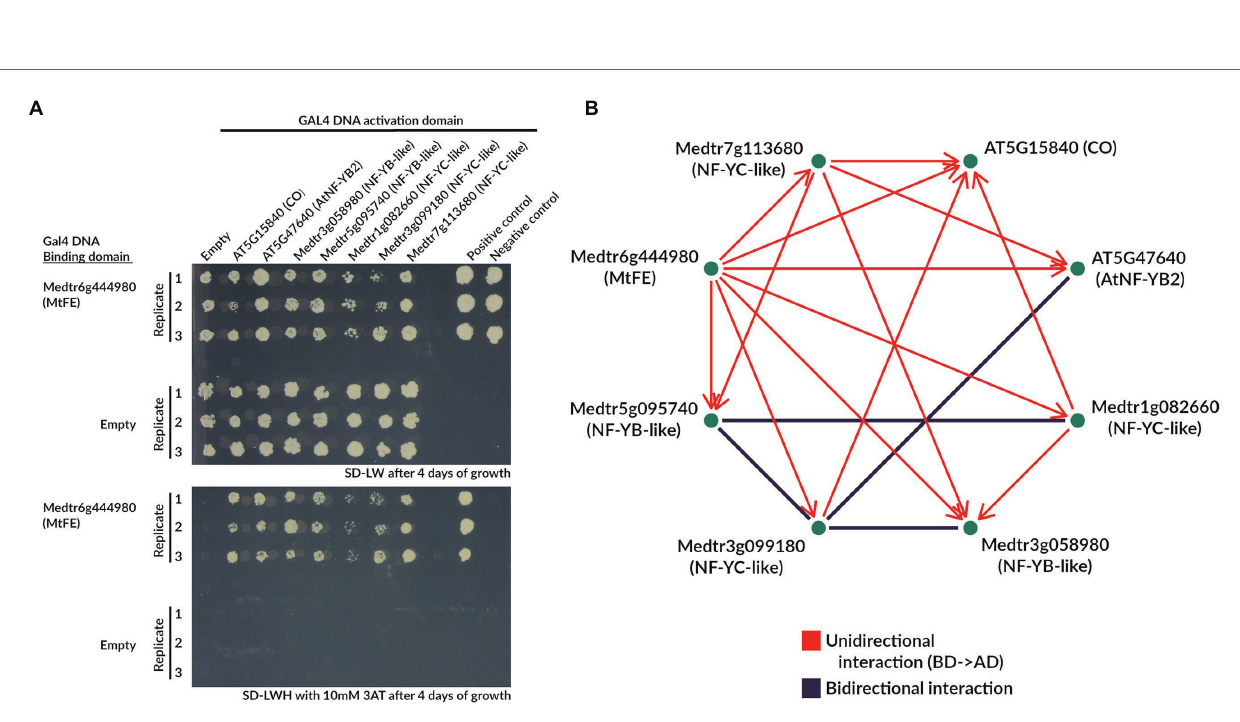
FIGURE 5 | MtFE acts upstream of LD induced FT-like genes. The mean expression ( n = three independent biological replicates) of (A) MtFTa1 , (B) MtFTb1 , (C) MtFTb2 , (D) MtFTa2 , (E) FTIP1-like ( Medtr0291s0010 ), and (F) NaKR1-like ( Medtr7g100450 ) in M. truncatula NF5076 Mtfe plants at two different ages (14 and 26 days old). Expression is relative to the housekeeper PP2A . All plants were grown in VLD and error bars depict standard errors. Different letters indicate significantly different results from post hoc Tukey-adjusted comparisons of a linear model ( α = 0.05).